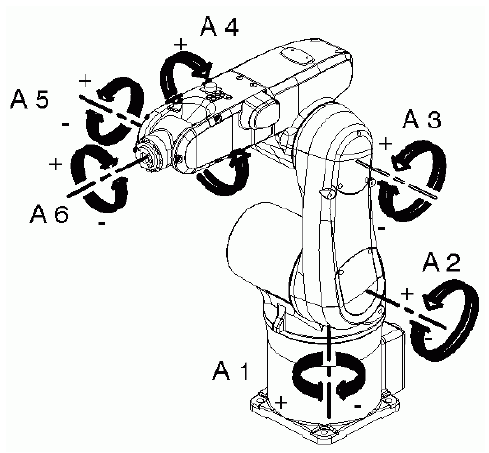
Figure 1. KR5-SIXX-R650 Axis. Provided by KR 5 sixx R650, R850 Specification